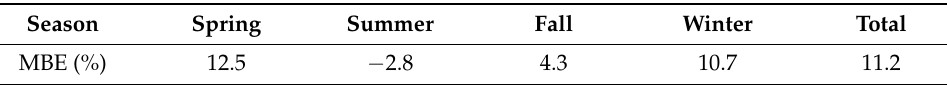
Table 6. Summary of the indicator for the